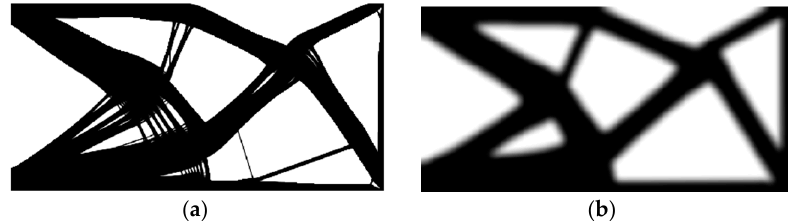
Figure 20. The final topology obtained using [35] with a small ( a ) and a large ( b ) filtering radius.